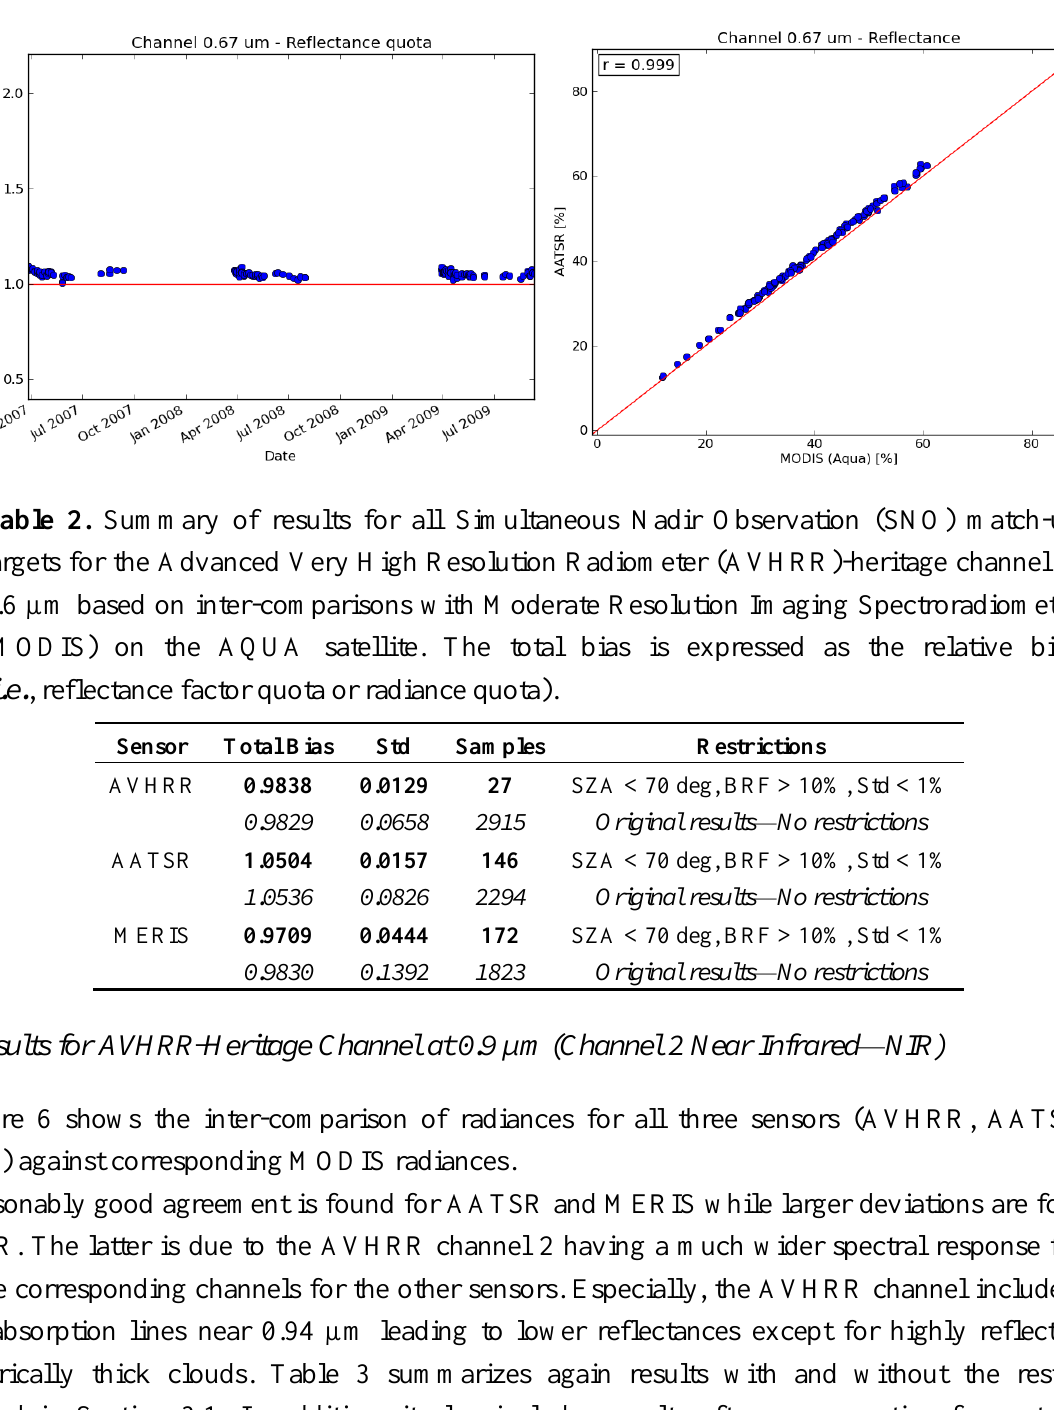
Figure 5. Inter-comparison of normalized reflectance factors against MODIS for the AVHRR-heritage channel at 0.6 µm for AATSR for the restricted dataset. Left panel shows results expressed as reflectance factor quotas over the full time series and right panel shows results expressed as a scatter plot.